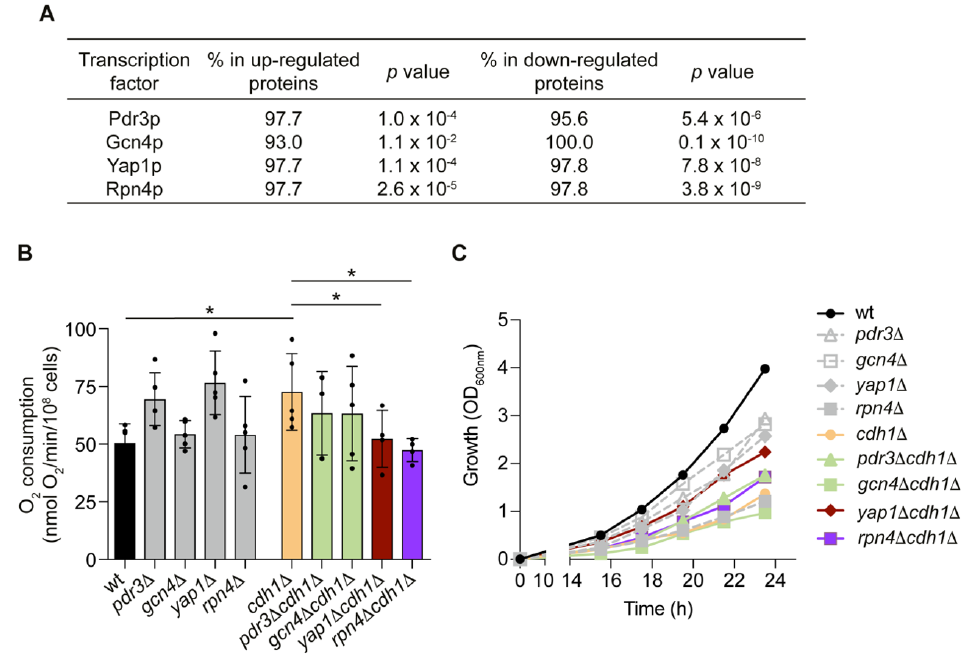
Figure 3. The transcription factors Yap1p and Rpn4p are required for the increase in mitochondrial respiration in the cdh1 ∆ mutant. ( A ) Table showing the YEASTRACT+ predicted transcription factors that might regulate the mitochondrial proteins altered in cdh1 ∆ cells. ( B ) Cells were grown until late-log phase and the respiratory rate was obtained measuring oxygen consumption rate in whole cells. Values are the mean ± SD ( n = 4); *, p < 0.05; one-way ANOVA followed by Tukey ’ s multiple- comparison test. ( C ) The growth of the indicated strains was monitored over time by optical density (OD 600nm ) measurements. Values are the mean ( n = 3).